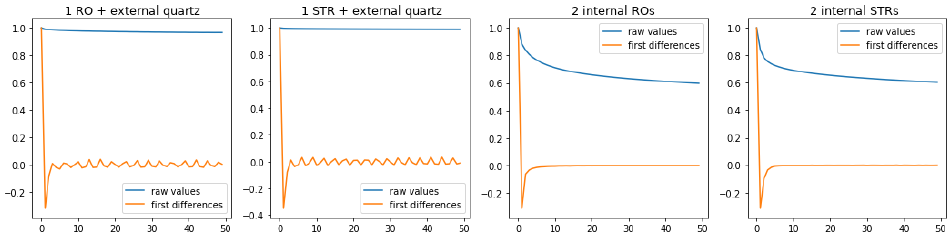
Figure 9: Autocorrelations of raw counter values and their first differences in the four hardware configurations. At lag 0, the correlation is by definition always equal to